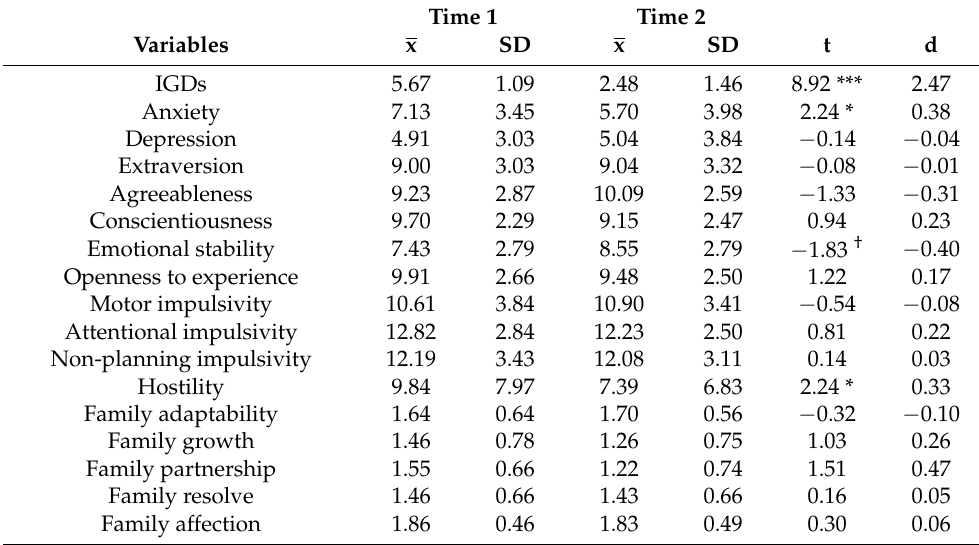
Table 5. Difference of means in the variables evaluated between T1 and T2 for the remission group. Time 1